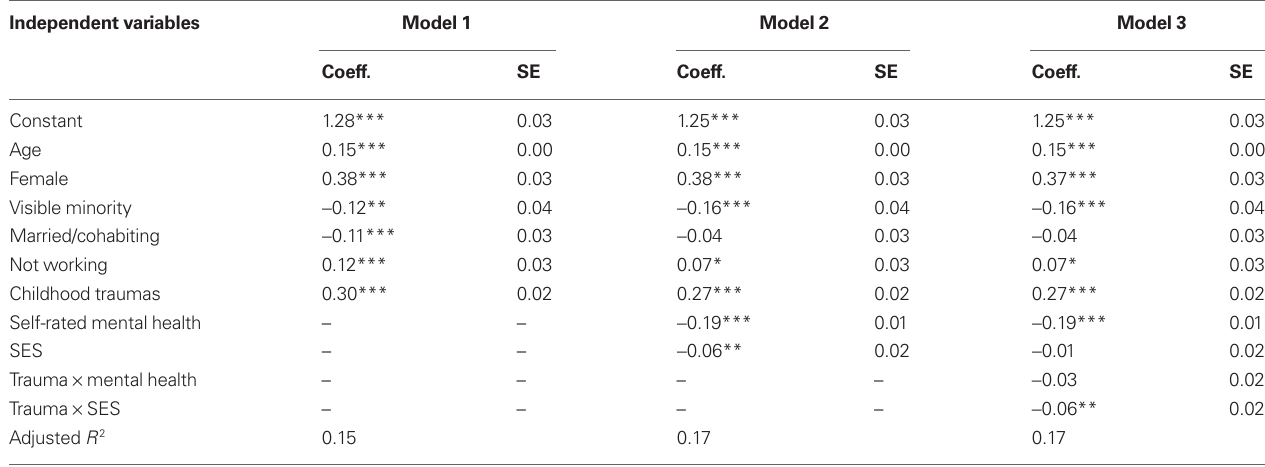
Table 1 | unstandardized coefficients for regression models examining associations of demographics, childhood traumas, mental health, and socioeconomic status with chronic